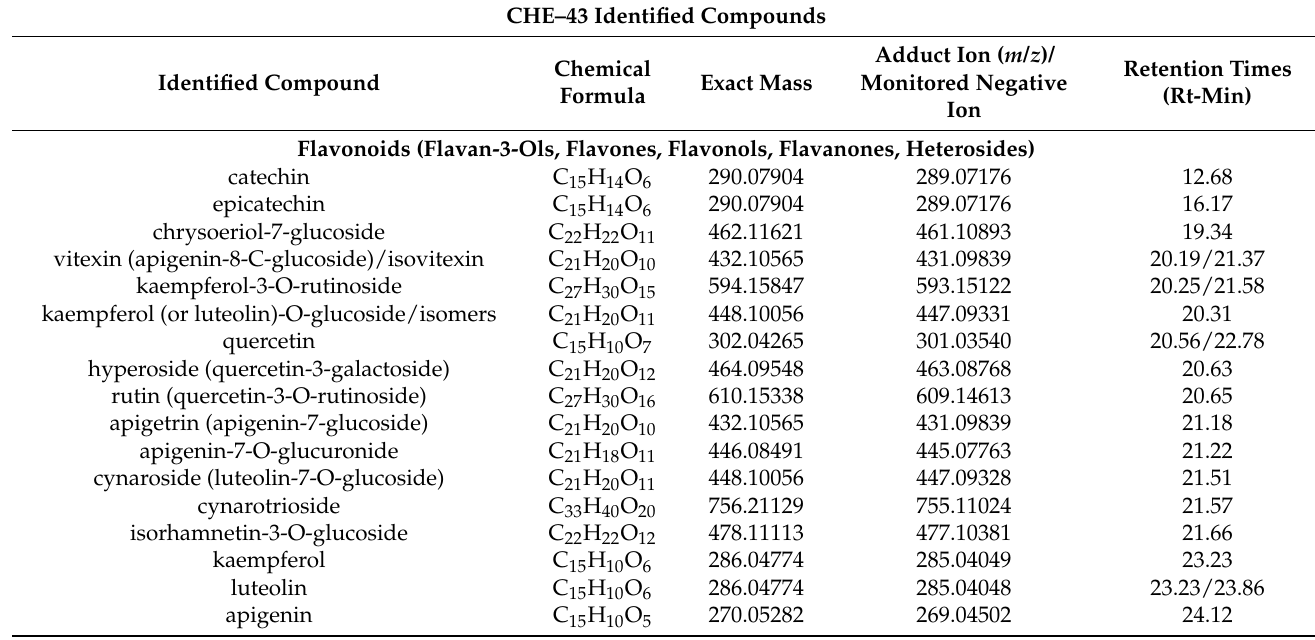
Table 5. Chemical compounds identified in CHE by